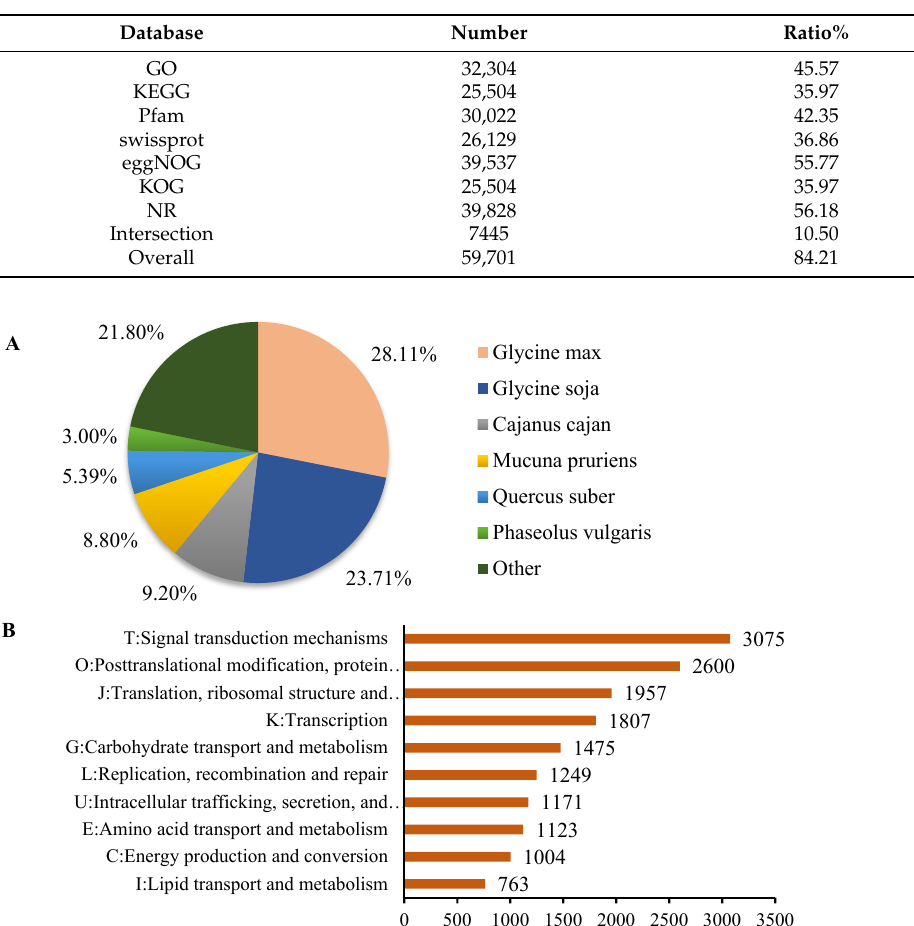
Table 1. Database Annotation Result Statistics.